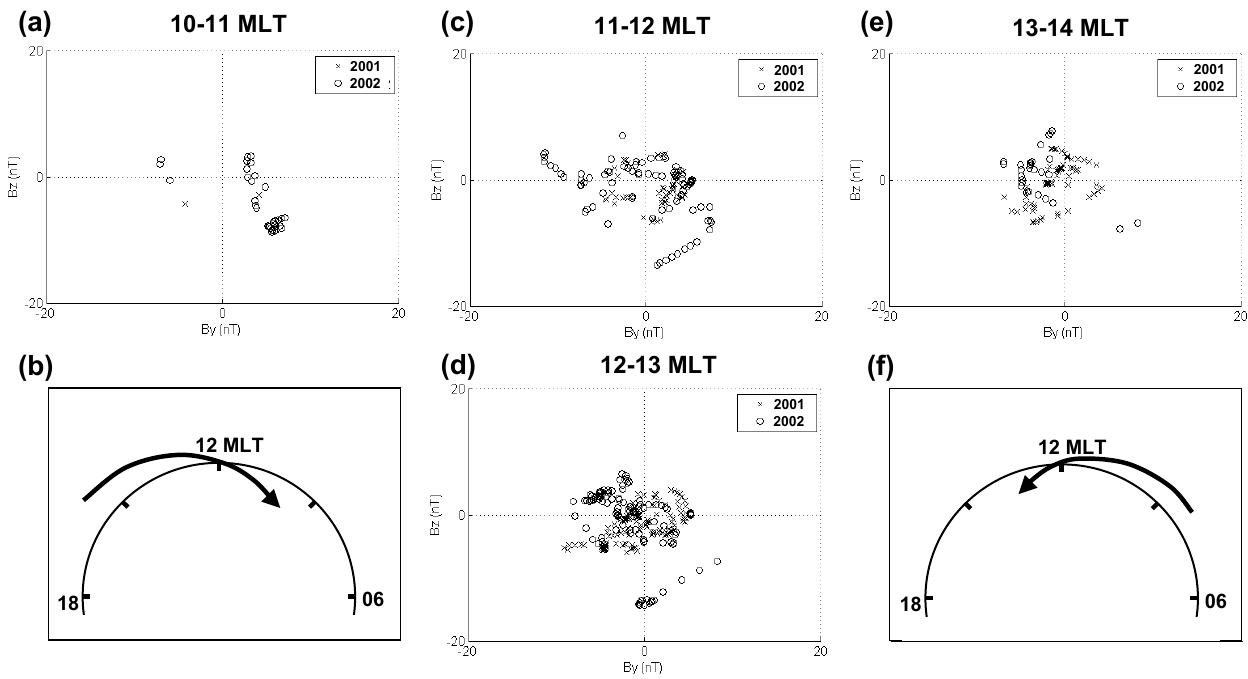
Fig. 2. Panels (a) , (c) , (d) and (e) represent IMF B Y / B Z scatter plots for the occurrence of extreme values of N m F 2 . There is a clear IMF B Y asymmetry in prenoon (10:00–11:00MLT) and postnoon (13:00–14:00MLT) that can be explained by transport of high density plasma away from noon as schematically illustrated in panels (b) and (f)